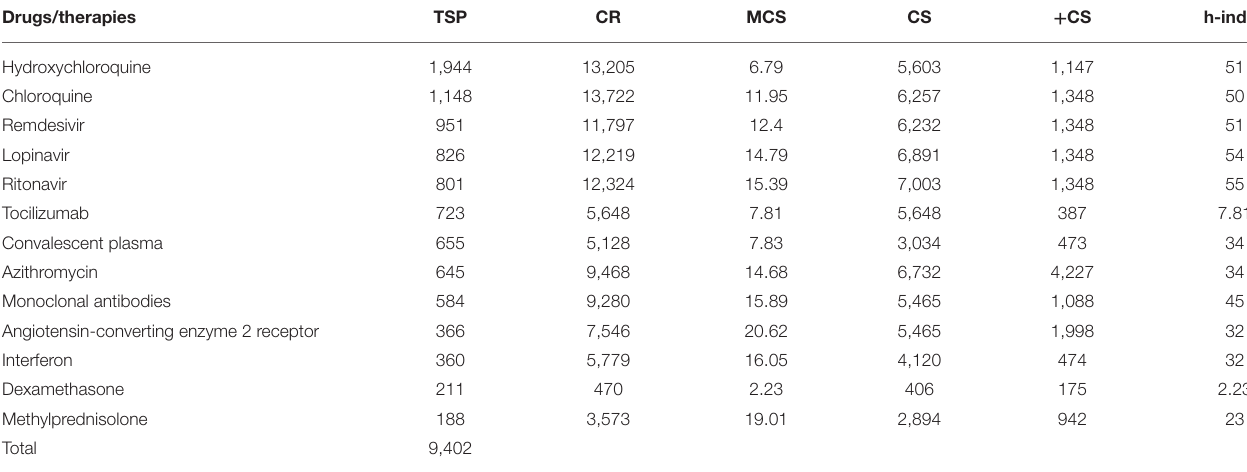
TABLE 1 | Number of documents on drugs and SARS-CoV-2/COVID-19 (26/12/2020). Years